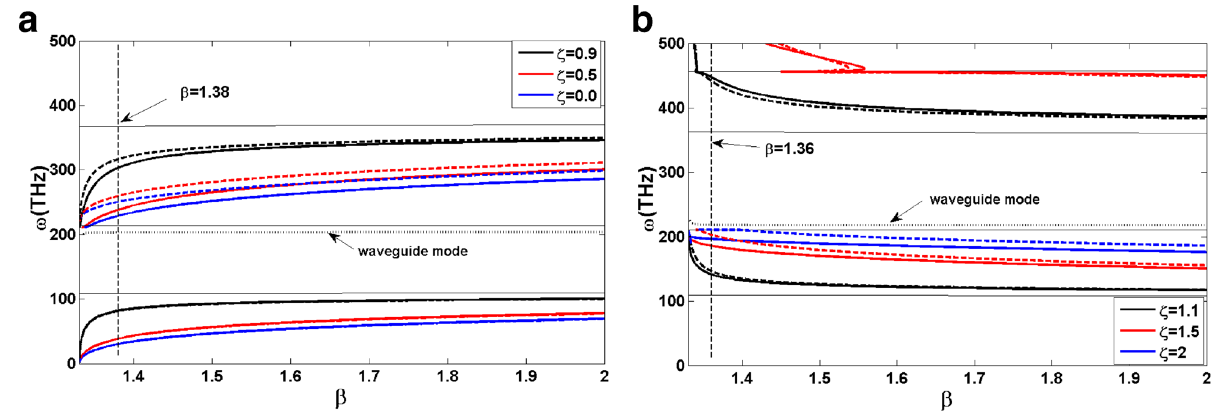
0.15eV , v 10 6 m/s , Figure 2. SPP dispersion of TWSM thin film in the Voigt configuration with E f f = = 0.57˚A 1 , a 24 , ε 0 6.2 , ε 3 , 2 b 0.1 µ m , ε 1 1, ε 3 ( 1.33 ) 2 . Panels ( a ), ( b ) correspond to type-I g c = − = = = = = = and type-II TWSM for different values of ζ , respectively. The solid lines denote positive wave vector q > 0 and the dashed lines are for q < 0 . The thin gray curves correspond to bulk plasmon